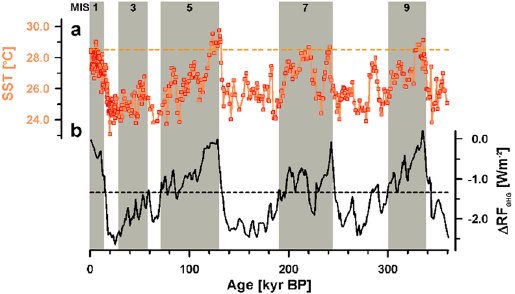
Figure 2. MD05-2925 SST values and Δ RF GHG of greenhouse gases. ( a ) Mg/Ca-inferred SST in the Solomon Sea. ( b ) Calculated Δ RF GHG (see Methods). Gray bars indicate interglacial periods. The orange and black dashed lines are the modern annual average SST (28.5 °C) and the CO 2 = 220 ppm, respectively.